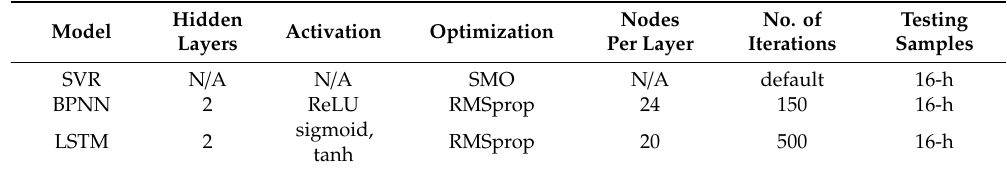
Table 3. Hyper-parameters for selected models.